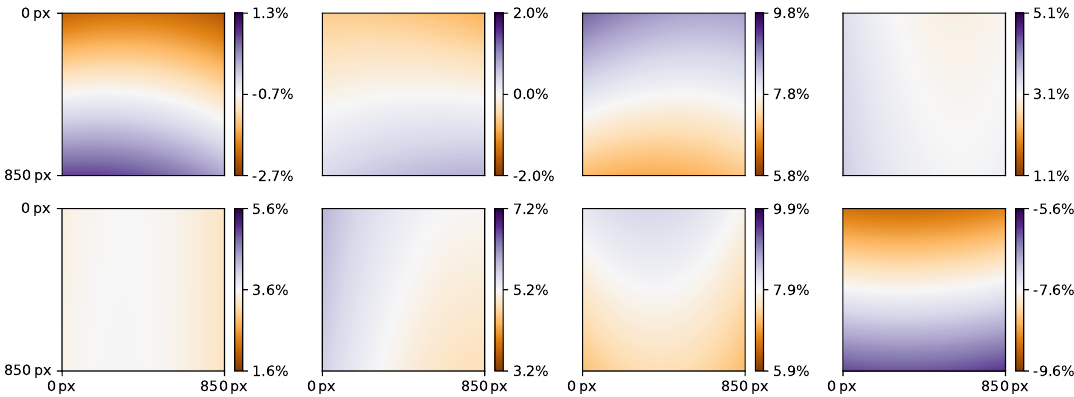
Figure 11. Relative deviations of the actual phase steps from the intended step width of 2 π the first nine frames of the phase stepping series ( 5 have been determined by optimization of Equation (18) assuming the spatial dependence defined by Equation (19) (see also Algorithm